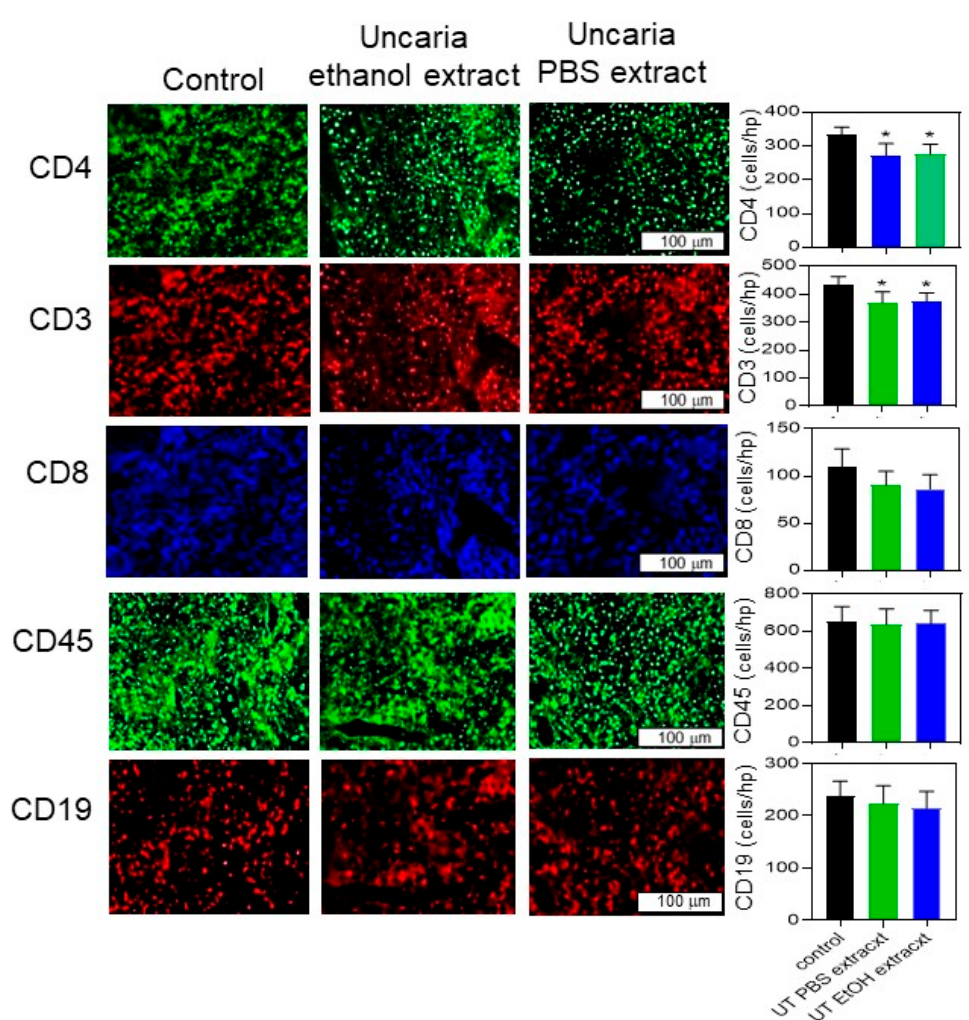
Figure 7. Histochemical analysis of infiltrating immune cells in sections of B16-BL6 tumours isolated from mice treated with Uncaria tomentosa extracts. Histochemical analysis was performed on B16-BL6 tumour tissue from mice treated with vehicle, the resuspended ethanol extract, or the resuspended PBS extract of Uncaria tomentosa and typical microscopic fields shown. Tissue sections were stained with fluorescence-labelled antibodies against T-cell markers including CD4 (T helper cells), CD3 (pan T cells), and CD8 (cytotoxic T cells), and leukocyte markers including CD45 (pan leukocytes) and CD19 (B cells). The number of labelled cells/hpf was counted from 8 different fields and the mean and standard deviation determined for each condition is shown in the bar graphs. One-way ANOVA and post hoc Tukey analysis were performed to reveal any significant differences (*) in the number of cells between conditions ( p < 0.05).